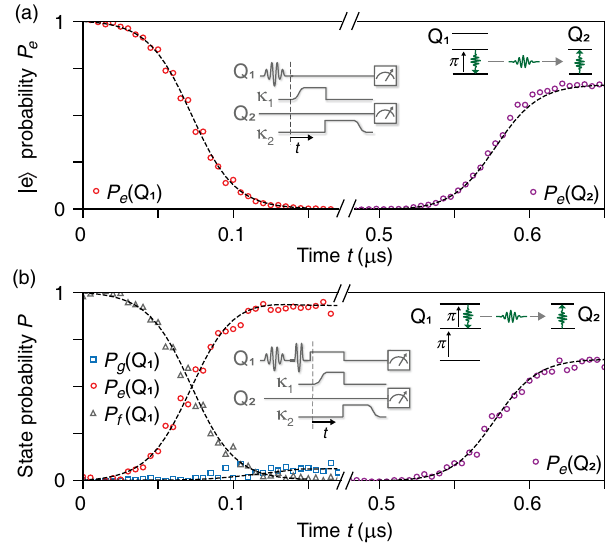
FIG. 3. Which-path heralding. (a) After exciting Q 1 to j e i with ω ¼ 2 π × 3 . 95 GHz, Q ’ s tunable coupling κ 1 1 is modulated ge dynamically to release a symmetric phonon wave packet with characteristic time 1 = κ ¼ 15 ns on Q 1 ’ s g - e transition. The emitted phonon is later captured by Q 2 on its g - e transition. (b) Inset pulse sequence: We initialize Q 1 to j f i using two sequential pulses at the g - e and e - f transition, with ω ¼ ω − j α j ¼ 2 π × 3 . 97 GHz. We then modulate κ 1 to emit ef ge a phonon on Q 1 ’ s e - f transition. The emitted phonon is later captured by Q 2 on its g - e transition. During this process, Q 1 ’ s j g i population increases from 0 to 0.06 due to spurious relaxation from j e i to j g i . Insets show the pulse sequences and schematics of the expected transfers. Open symbols represent the qubits ’ populations measured at time t , dashed lines correspond to a numerical model taking into account the qubits ’ decoherence and phonon